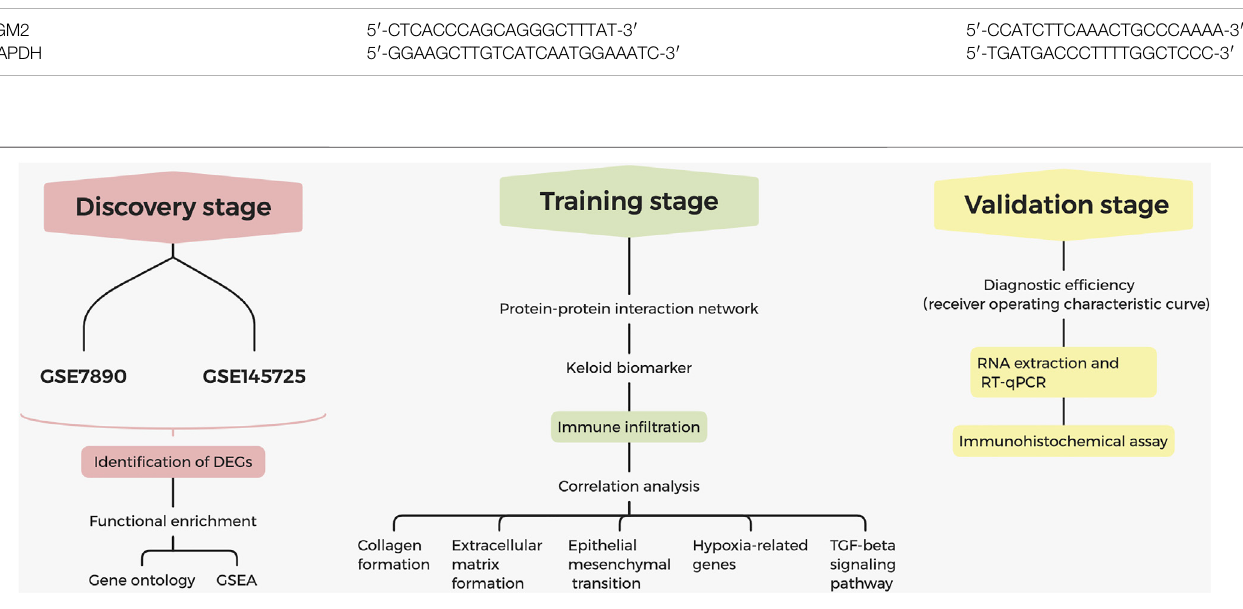
FIGURE 1 | Flowchart for identi fi cation of diagnostic signatures in